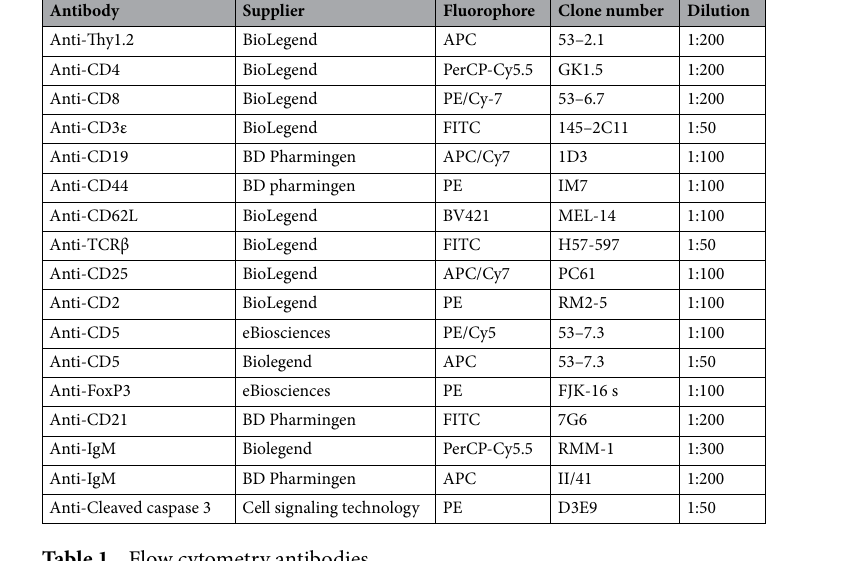
are listed in Table 1. Flow cytometry data was acquired on a BD FACSCanto II and analysed using FlowJo Ver- sion 10 software. Live lymphocytes were gated based on SSC-A and FSC-A and then doublets excluded based